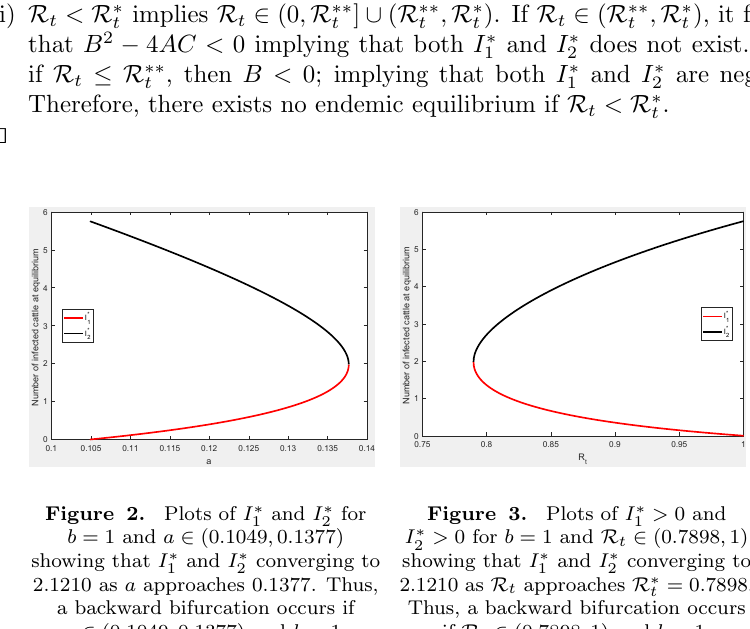
for and I ∗ > 0 and Figure 2. Plots of I ∗ Figure 3. Plots of I ∗ 2 1 1 b = 1 and a ∈ (0 . 1049 , 0 . 1377) I ∗ > 0 for b = 1 and R t ∈ (0 . 7898 , 1) 2 showing that I ∗ and I ∗ converging to showing that I ∗ and I ∗ converging to 1 2 1 2 2 . 1210 as a approaches 0 . 1377. Thus, 2 . 1210 as R t approaches R ∗ t = 0 . a backward bifurcation occurs if a ∈ (0 . 1049 , 0 . 1377) and b = 1.